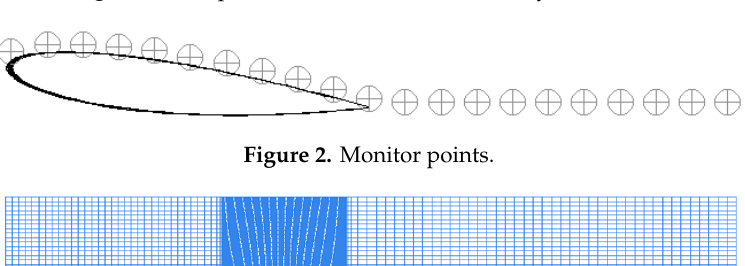
Figure 1. Computational domain and boundary conditions.